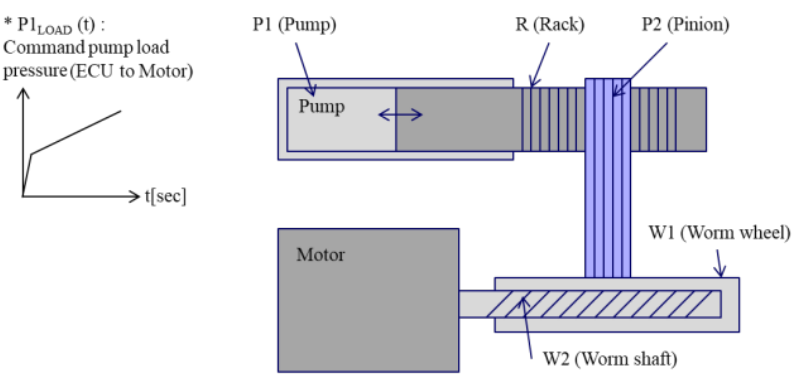
Figure 11. Concept of the motor and pump gear system of the integrated brake system. * p < 0.05 .